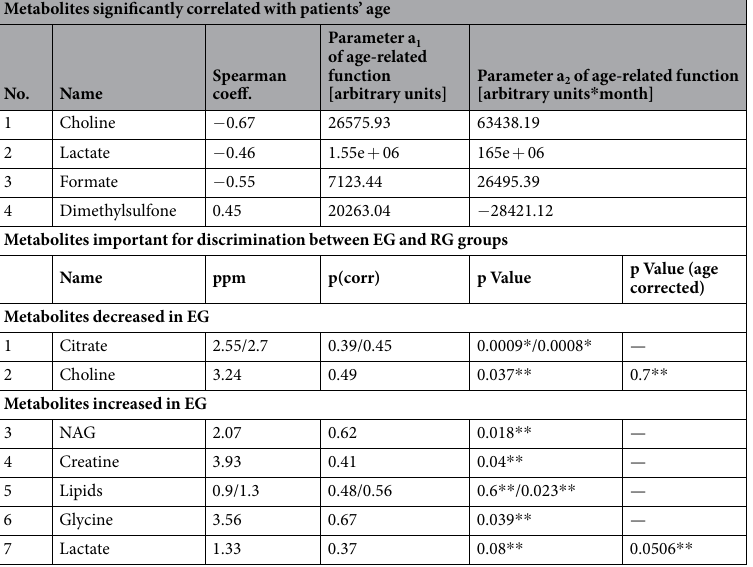
Table 3. List of metabolites with age dependent concentrations and discriminant metabolites based on the OPLS-DA analysis. * t student test, ** Mann-Whitney U